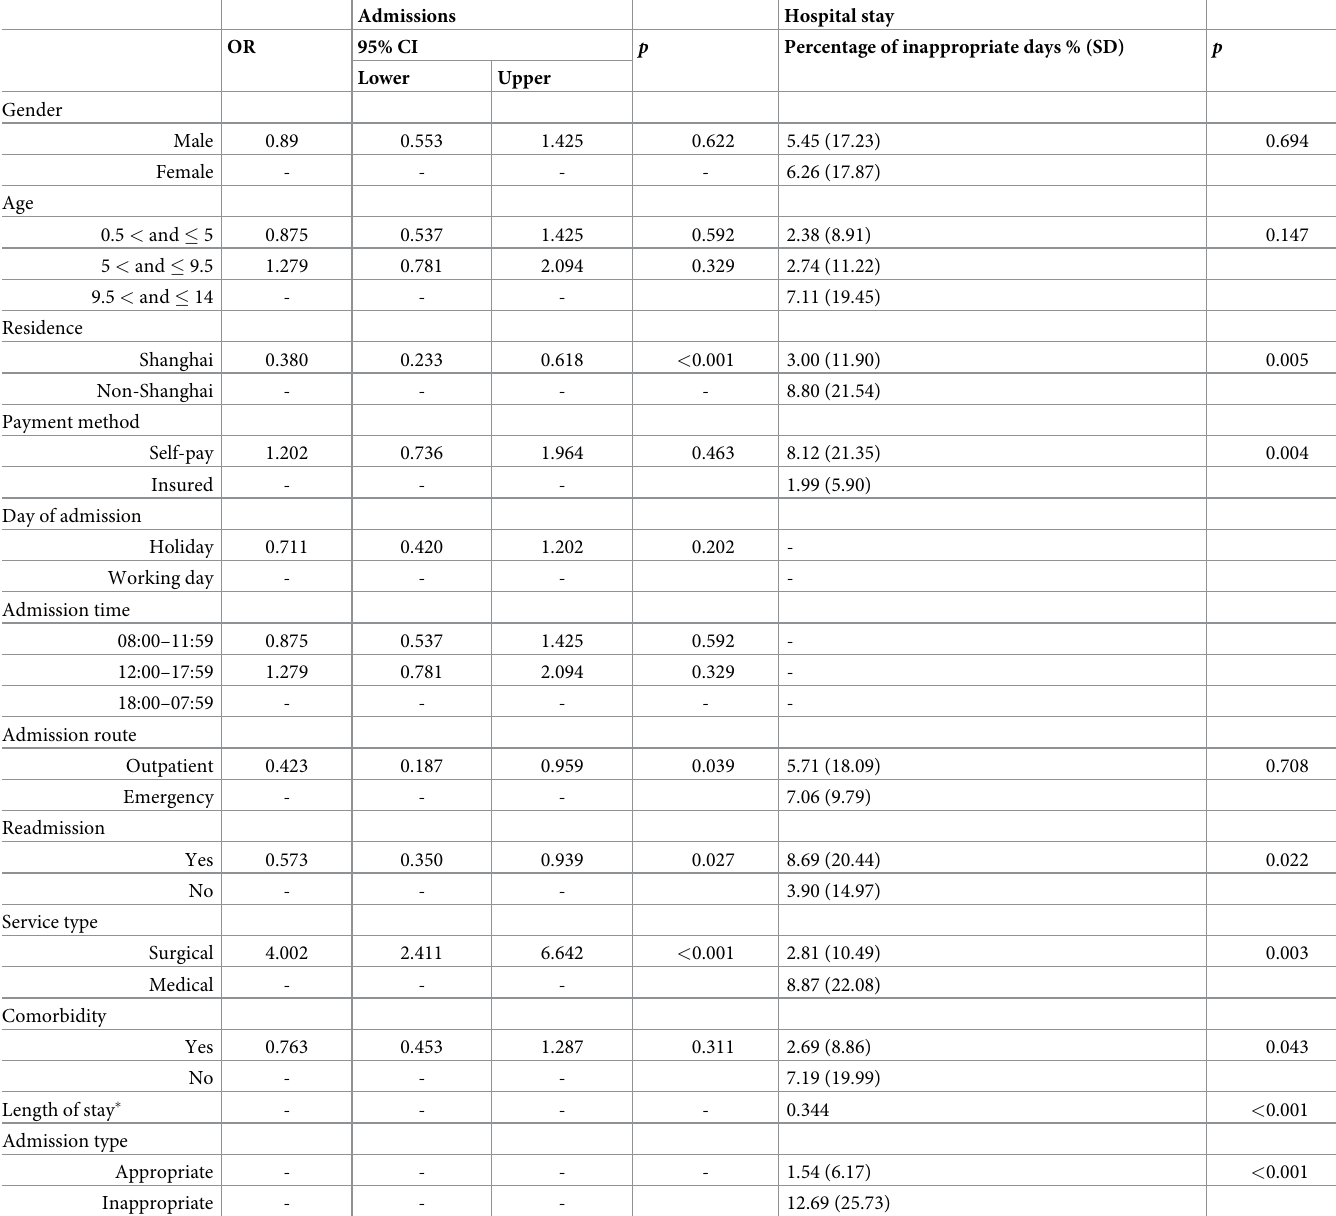
Table 2. Univariate analysis